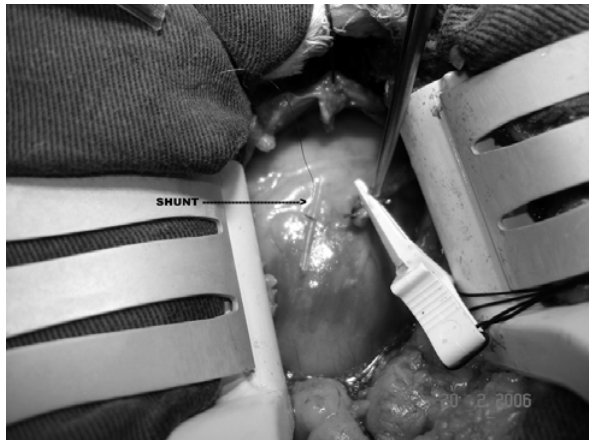
Fig. 2 - Perfusor ("shunt") intracoronariano